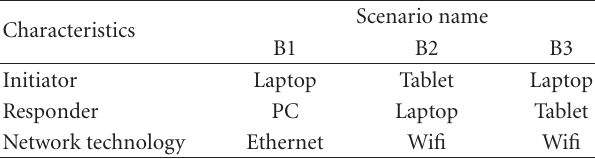
Table 2: Subscenarios B1, B2, and B3